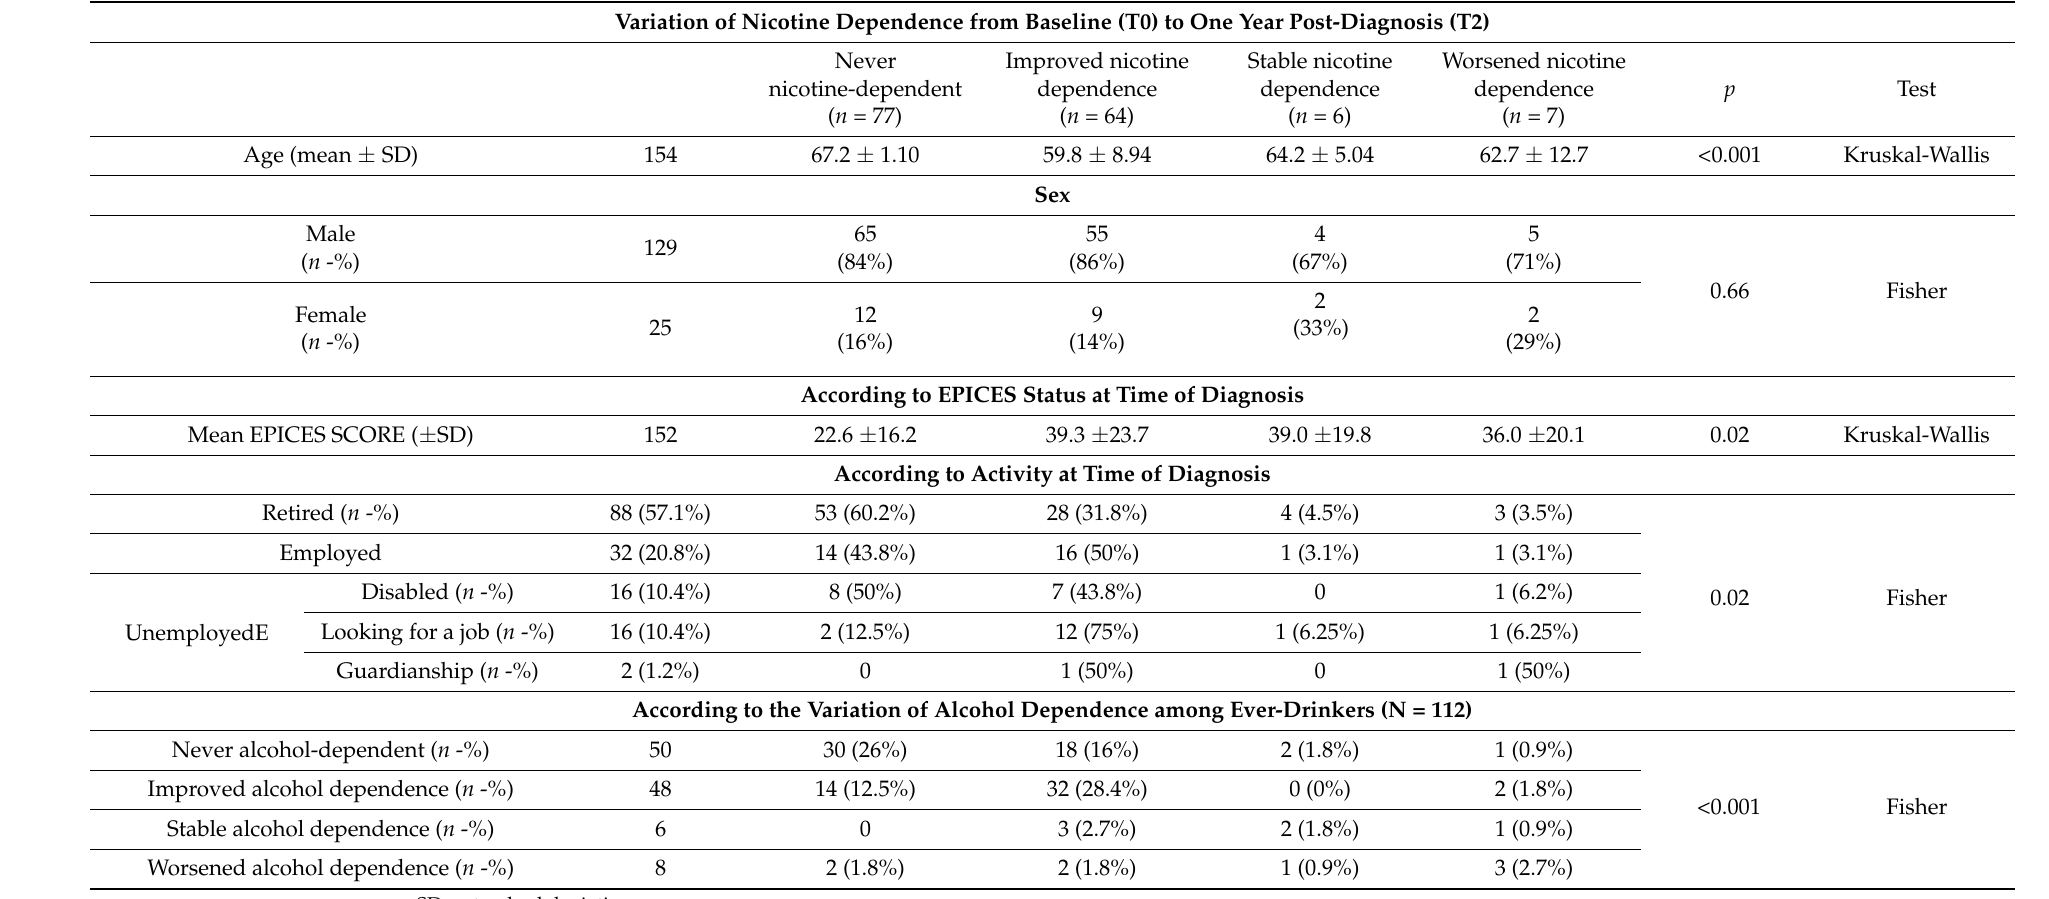
Table 2. Variation of the nicotine dependence according to the Fagerström score, monitored in 154/155 ever-smokers (willing to undergo the Fagerström test) at time of diagnosis and within one year from the